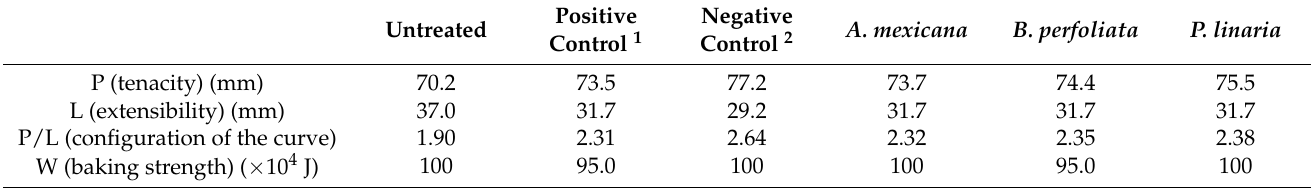
Table 6. Alveogram characteristics of the flour obtained from wheat treated with essential oils. Positive Untreated